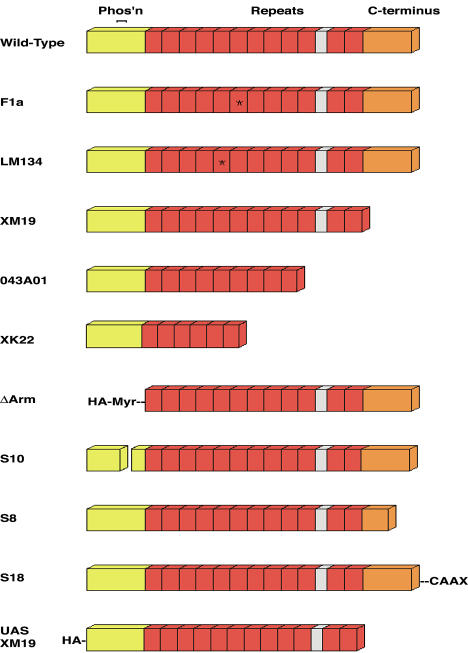
Structure of Arm Protein and AllelesArm protein consists of three regions. The N-terminus is required for transactivation, for phosphorylation-based and proteasome-mediated degradation, and for α-catenin binding. The central repeats region is a superhelical structure that contains the binding sites for most of Arm's binding partners, including APC, TCF, Cadherin, and Axin. The C-terminus is required for Cby and Teashirt binding and transactivation. The armF1a mutation causes an arginine-to-histidine change within repeat six. The armLM134 mutation causes a serine-to-phenylalanine change in repeat five. The “weak” allele armXM19 removes the entire C-terminus. The “medium” allele armO43A01 causes early termination within repeat nine. The “strong” allele armXK22 causes early termination within repeat six. The ArmΔArm transgene consists of the entire repeats region and C-terminus fused to an HA tag and myristoylation sequence at the N-terminus under GAL4/UAS control. The ArmS10 transgene contains a small deletion in the N-terminus, which removes the four phosphorylation sites necessary for degradation and is under GAL4/UAS control. The ArmS8 transgene contains a deletion of approximately a third of the C-terminus and is under endogenous promoter control. The ArmS18 transgene contains the entire Arm sequence fused to the CAAX myristoylation sequence of Ras and is under endogenous promoter control. The UAS–ArmXM19 is the equivalent of the armXM19 allele in deletion, but is fused to an N-terminal HA tag and is under GAL4/UAS control.